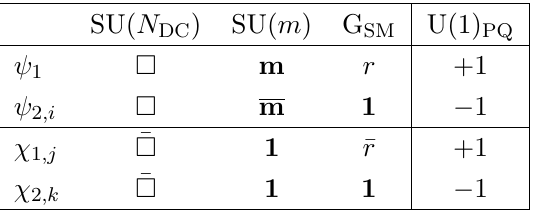
Composite axion model of ref. [17]. In the original work only QCD interactions were considered, with G = SU(3) and r = 3 ; the minimal GUT extension is obtained by taking SM c G = SU(5) and r = 5 . The fermions ψ appear in multiple copies, labelled by the indices SM 2 , χ 1 , χ 2 i = 1 , . . . , dim( r ) , j = 1 , . . . , m , k = 1 , . . . , m · dim( r )